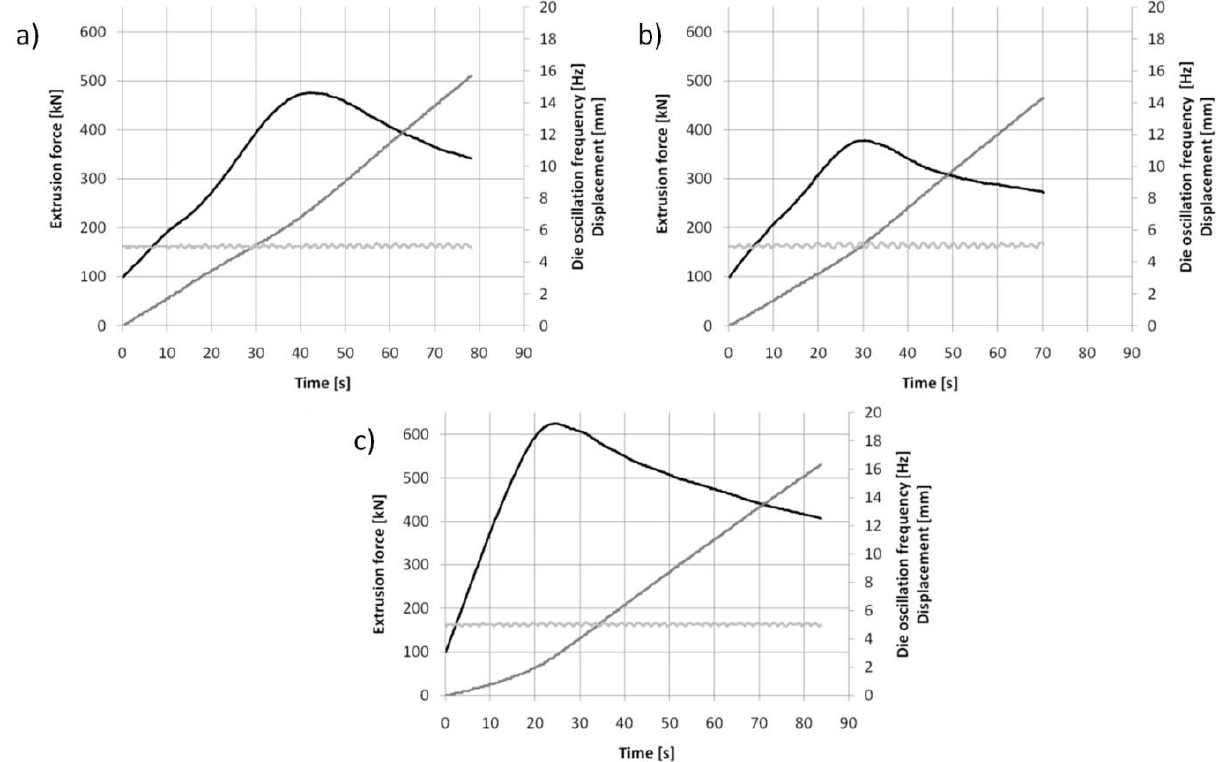
Figure 4. Curves of extrusion force vs. time registered for KOBO extrusion at room temperature with frequency 5 Hz, extrusion rate 0.2 mm/s, and extrusion ratio λ = 25 for: ( a ) compacted magnesium powder Mg(P), ( b ) sintered magnesium powder Mg(S), and ( c ) cast magnesium Mg(C).